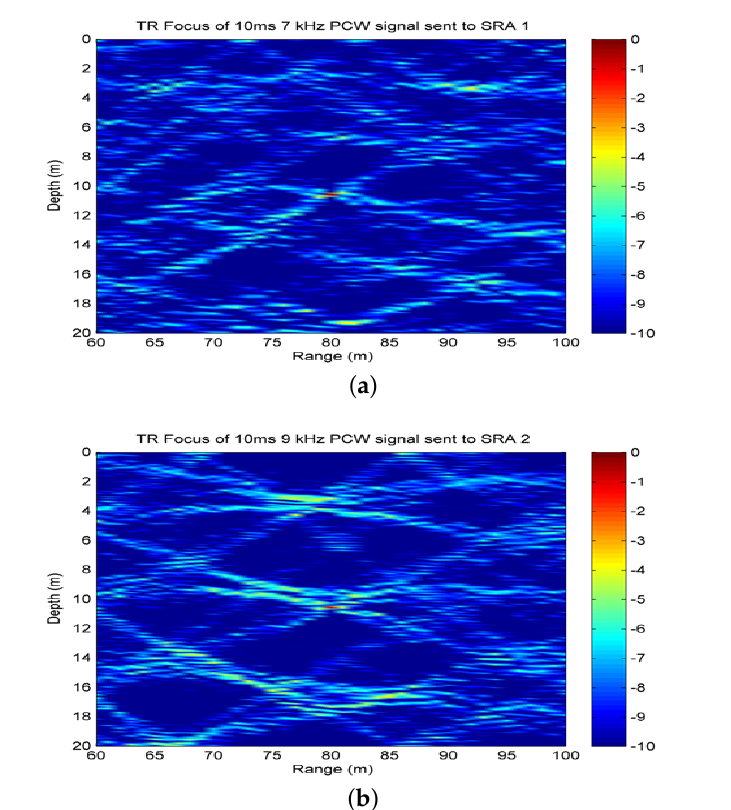
Figure 2. Time-reversal focusing with 10 ms PCW signals: ( a ) 7 kHz signal transmitted by SRA1 covering the water column from 1.4 to 15.4 m ; ( b ) 9 kHz signal transmitted by SRA2 covering the water column from 1.24 to 15.24